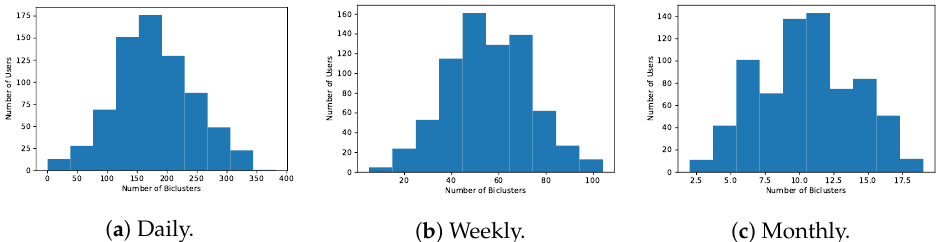
Figure 27. Number of patterns found for each user when combining the biclustering solutions with different pattern assumption at InfraQuinta, 2017.